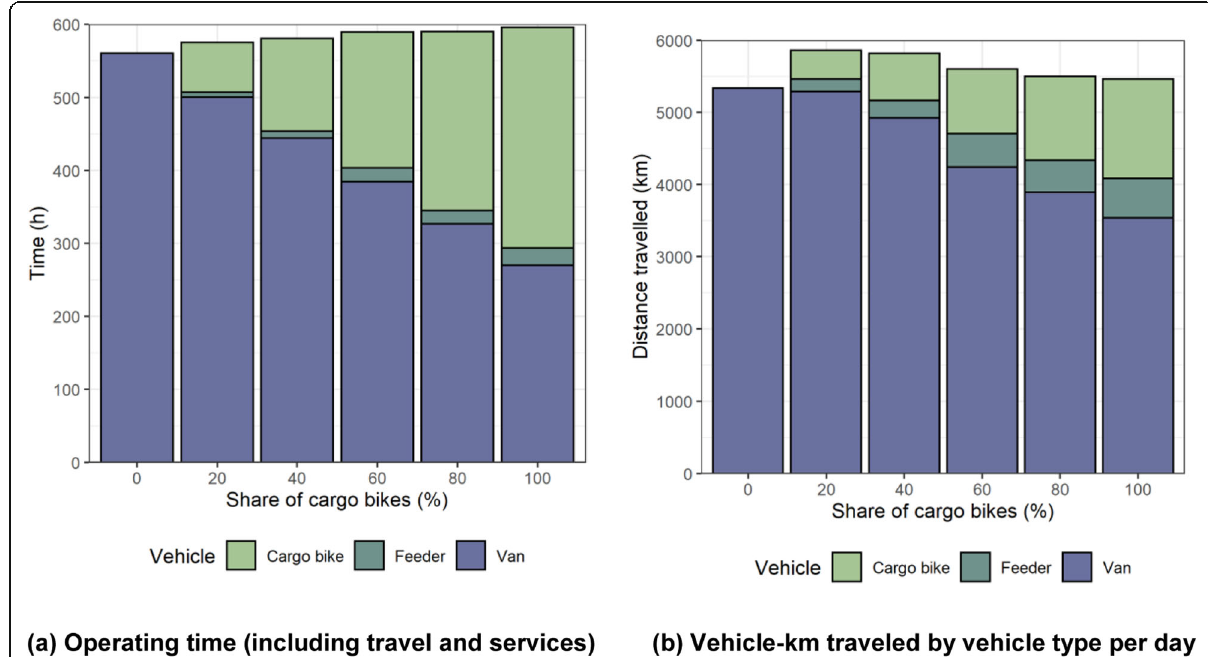
Fig. 6 Operational indicators for parcel distribution by vehicle type